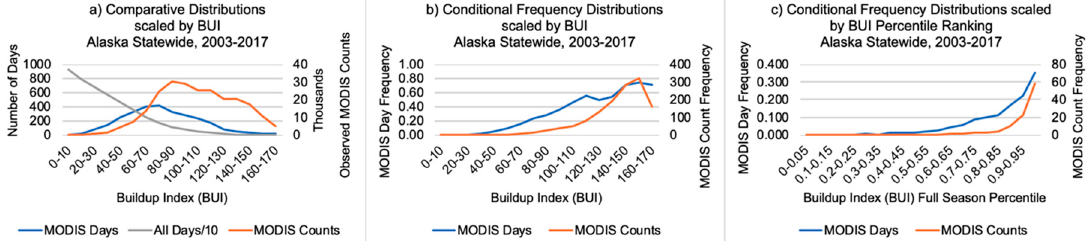
Figure 7. Comparison of frequency distribution for all days, MODIS Days, and MODIS active fire detection counts scaled by BUI. ( a ) Raw data distributions for all three. ( b ) Conditional frequency distribution scaled by BUI. ( c ) Conditional frequency distribution scaled by BUI percentile ranking.